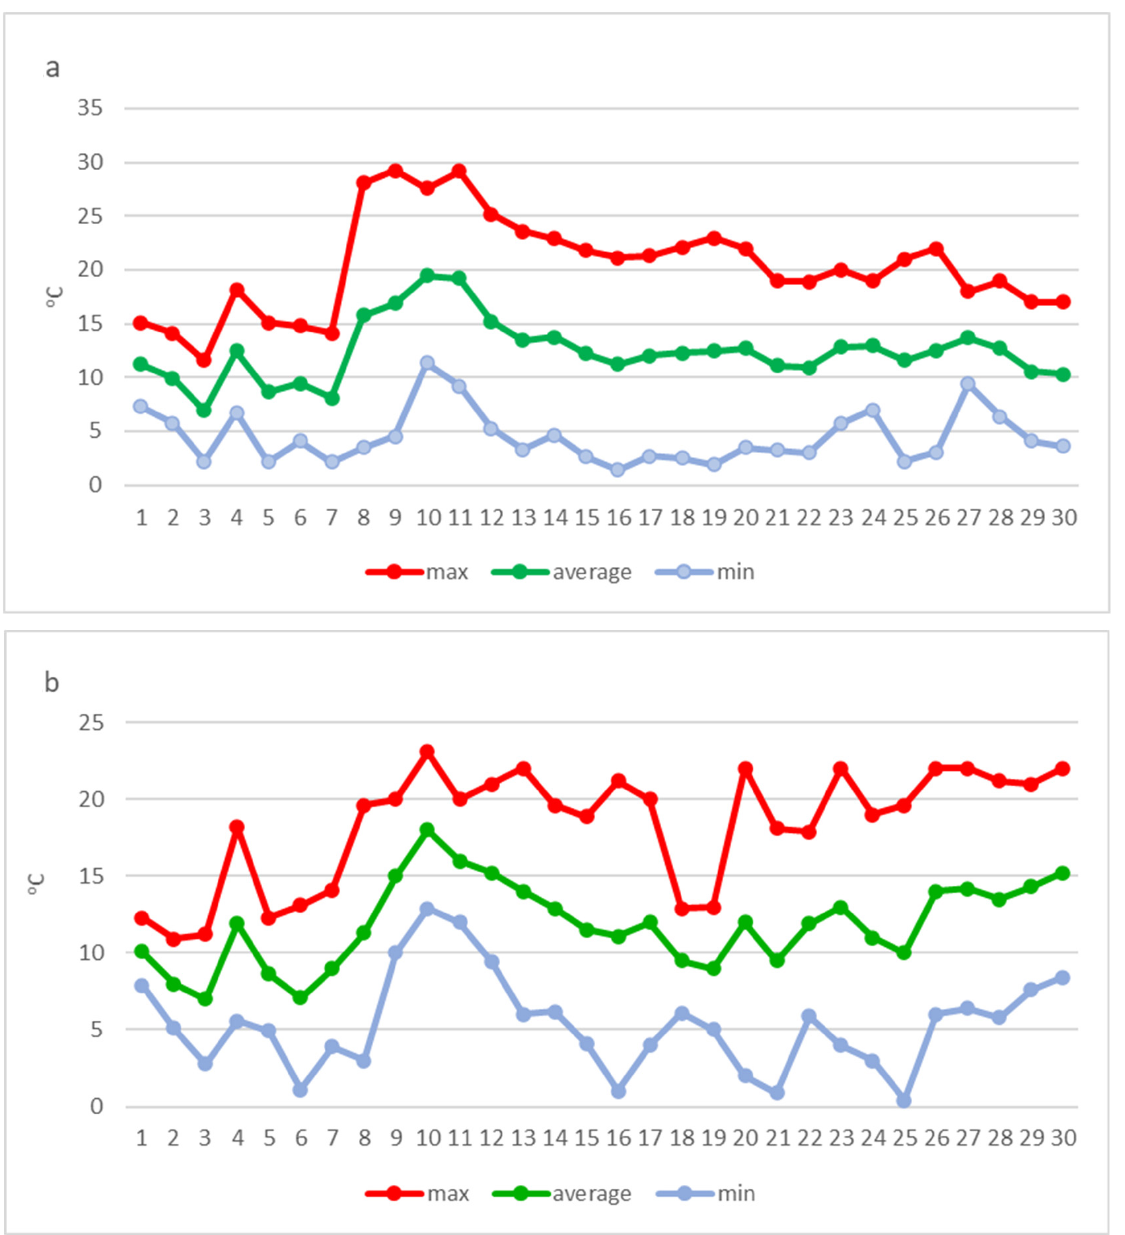
Figure 1. The maximum, average and minimum temperatures during the flowering. ( a ) The 1st year of the experiment; ( b ) the 2nd year of the experiment.